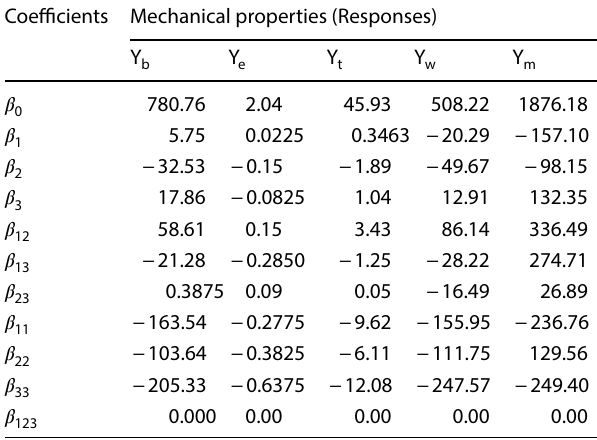
Table 10 Coefficients of responses: Y b , Y e , Y t , Y w , 𝐚𝐧𝐝 Y m are the breaking force, Elongation, Tenacity, Work done, and Modulus, respectively Coefficients Mechanical properties